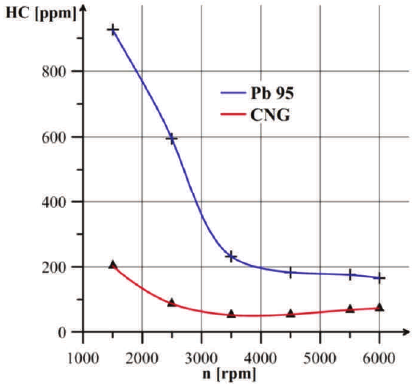
Fig. 6. Concentration of hydrocarbons in the Fiat 0.9 TwinAir engine exhaust gases, working with external speed characteristics and fuelled by petrol Pb 95 and CNG